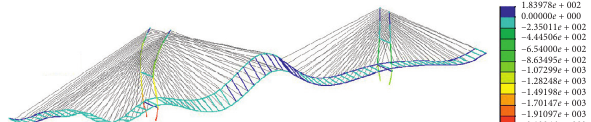
Figure 28: Stress distribution on pylons and the main girder after repair (unit: tonf/m 2 ).